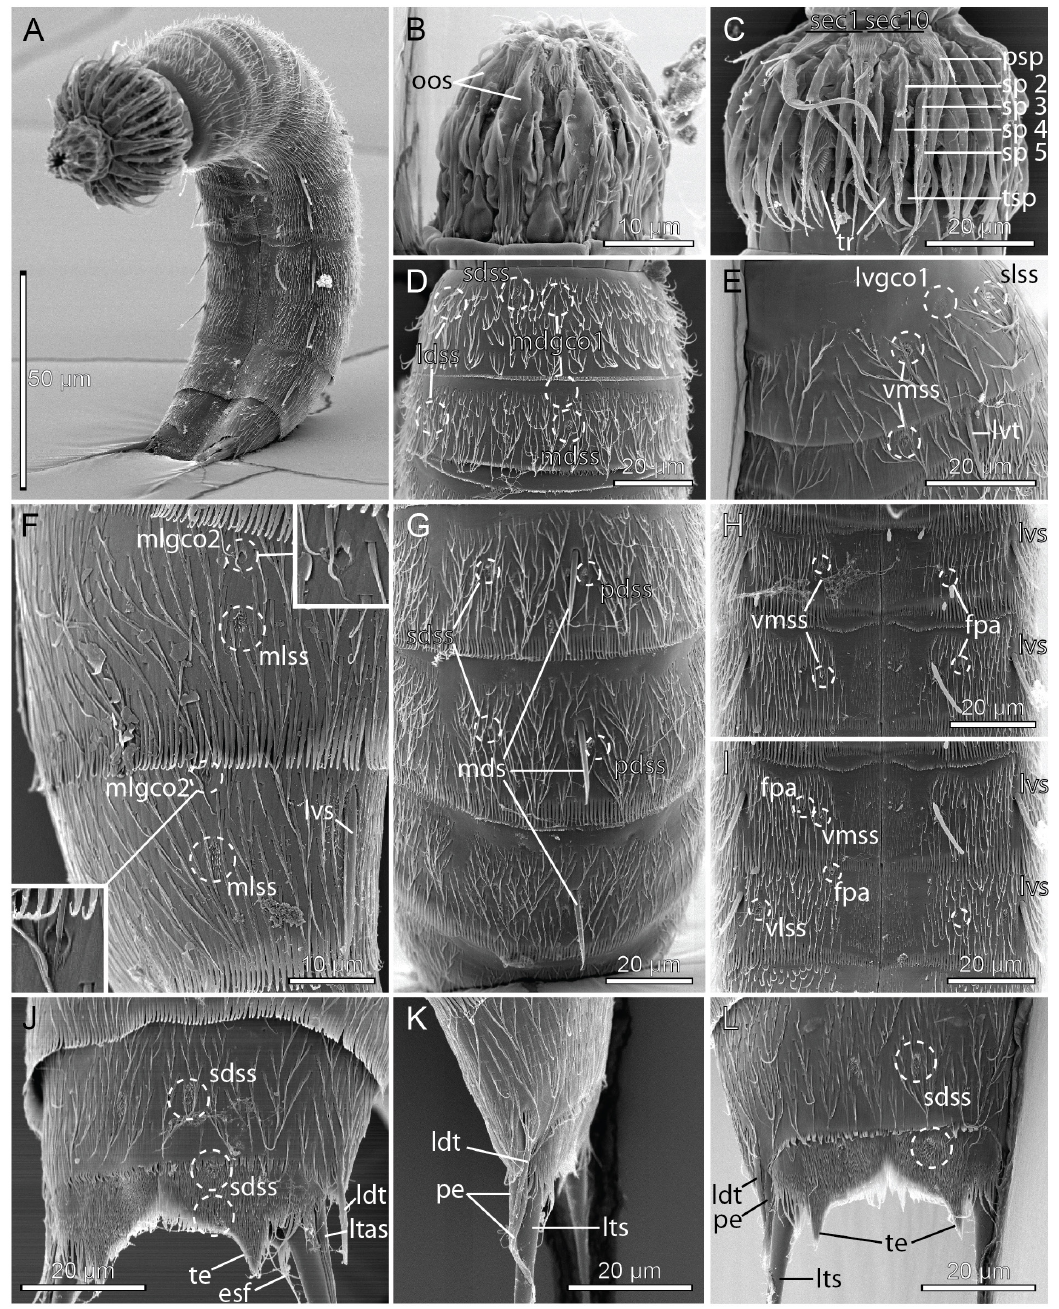
Fig. 15. Scanning electron micrographs showing overviews and details of Echinoderes sensibilis Adrianov et al ., 2002. A, D, F–J . ♀ ( MVS, personal reference collection). B–C, E, K–L . ♂ ( MVS, personal reference collection). A . Ventrolateral overview. B . Mouth cone, ventral view. C . Introvert sectors 1 and 10 (ventral). D . Segments 1 to 2, dorsal view. E . Segments 1 to 2, ventrolateral view. F . Segments 8 to 9, lateral view; insets show glandular cell outlets type 2. G . Segments 6 to 8, dorsal view. H . Segments 6 to 7, ventral view, showing female sexual dimorphism. I . Segments 7 to 8, ventral view, showing female sexual dimorphism. J . Segments 10 to 11, dorsal view, showing female sexual dimorphism. K . Segments 10 to 11, lateral view, showing male sexual dimorphism. L . Segments 10 to 11, dorsal view, showing male sexual